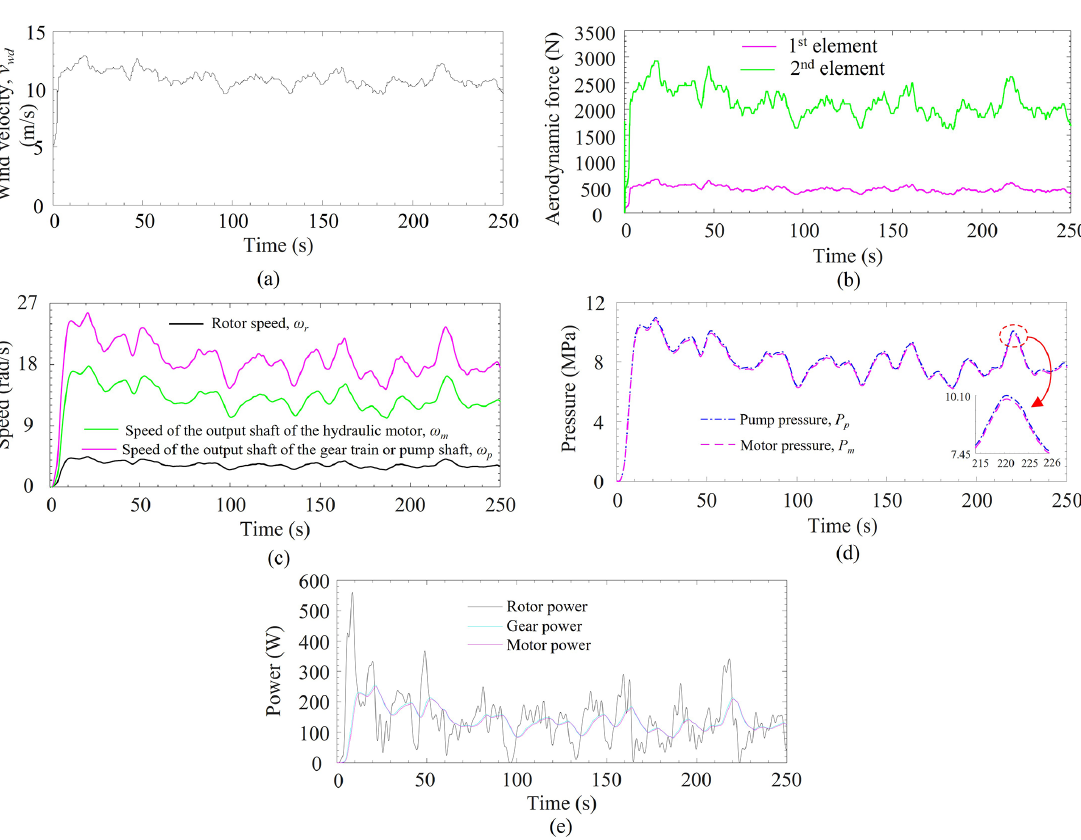
Figure 5. (a) Real wind velocity (Sanchez and Medina, 2014). (b) Aerodynamic forces. (c) Speed of turbine rotor, hydraulic pump, and hydraulic motor ( ω r , ω p , and ω m ). (d) Pressure at pump and motor plenum ( P p and P m ). (e) Power developed at rotor, gear, and motor